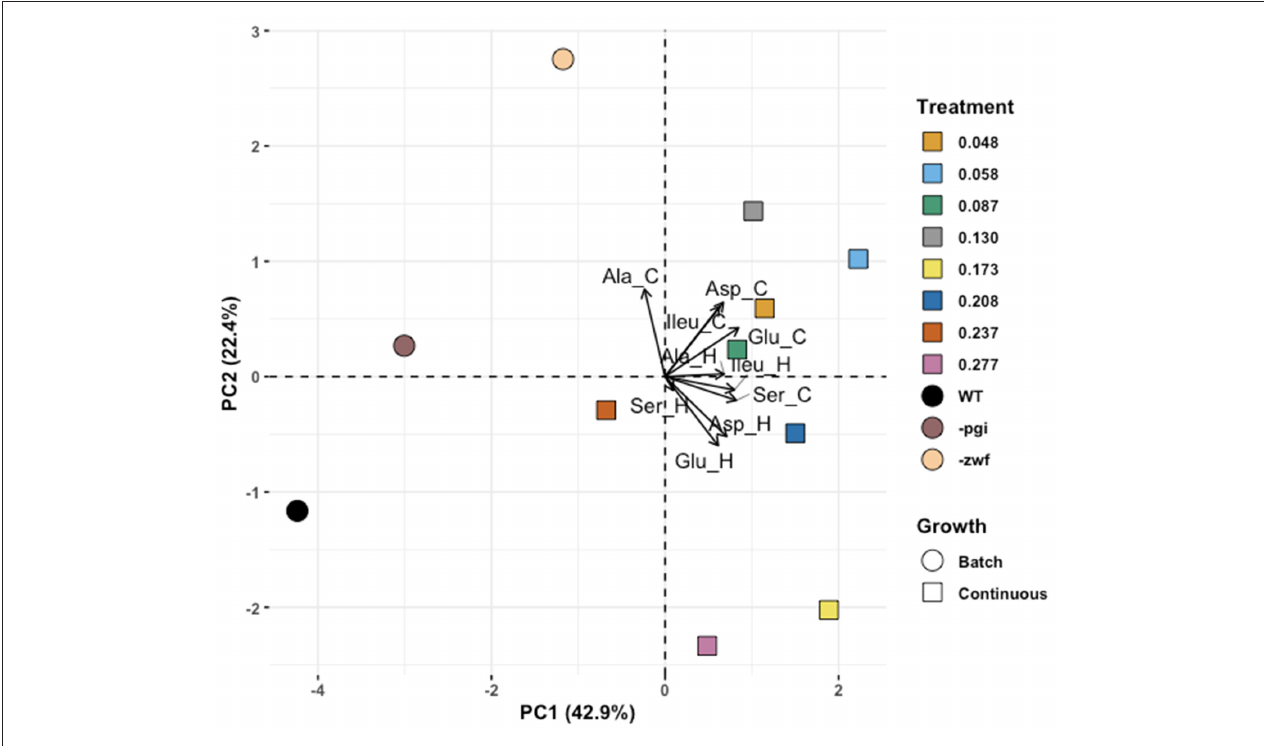
FIGURE 5 | Principle component analysis (PCA) exploring separations for amino acids in Escherichia coli MG1655 chemostat cultures and the WT strain along with mutant strains –pgi and –zwf in batch culture. Eigenvector labels include 3 letter amino acid code and “_C” and “_H” for the carbon and hydrogen isotope composition of that amino acid,